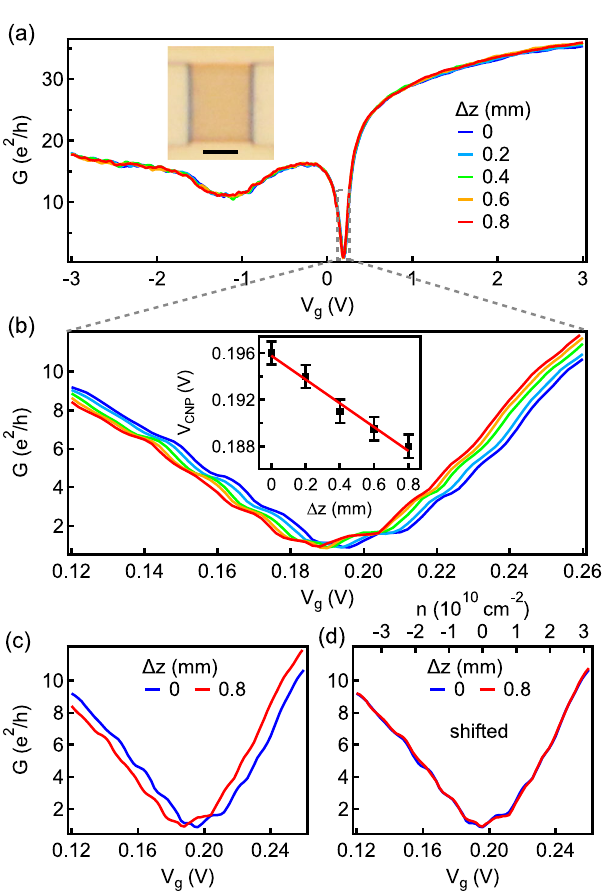
Fig. 2 Low-temperature transport measurements. a Two-terminal differential conductance G as a function of the gate voltage V g for different displacement Δ z . Inset: optical image of the measured device, scale bar: 2 μ m. b Zoom-in on the charge neutrality point (CNP). Inset: position of the CNP ( V CNP ) as a function of Δ z . V CNP is extracted as the gate voltage of minimum conductance. The error bars are estimated from half of the measurement step size in V g . Red line is a linear fi t with a slope of about − 10 mV per mm. c Zoom-in on the CNP for Δ z = 0 and Δ z = 0.8 mm. d Same data as in ( c ) with the Δ z = 0.8 mm curve (red) shifted to the right by + 8 mV in V g . The corresponding carrier density is shown on the top axis.